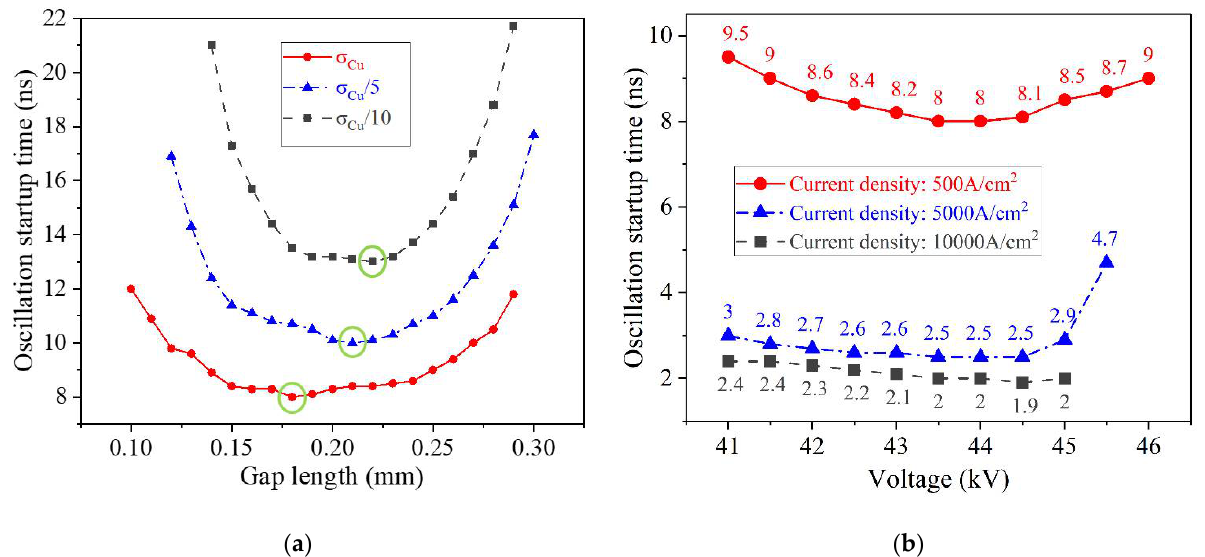
Figure 10. ( a ) The shortest OST versus gap length for different conductivity materials; ( b ) The variation trend of the shortest OST with voltage at different current densities.